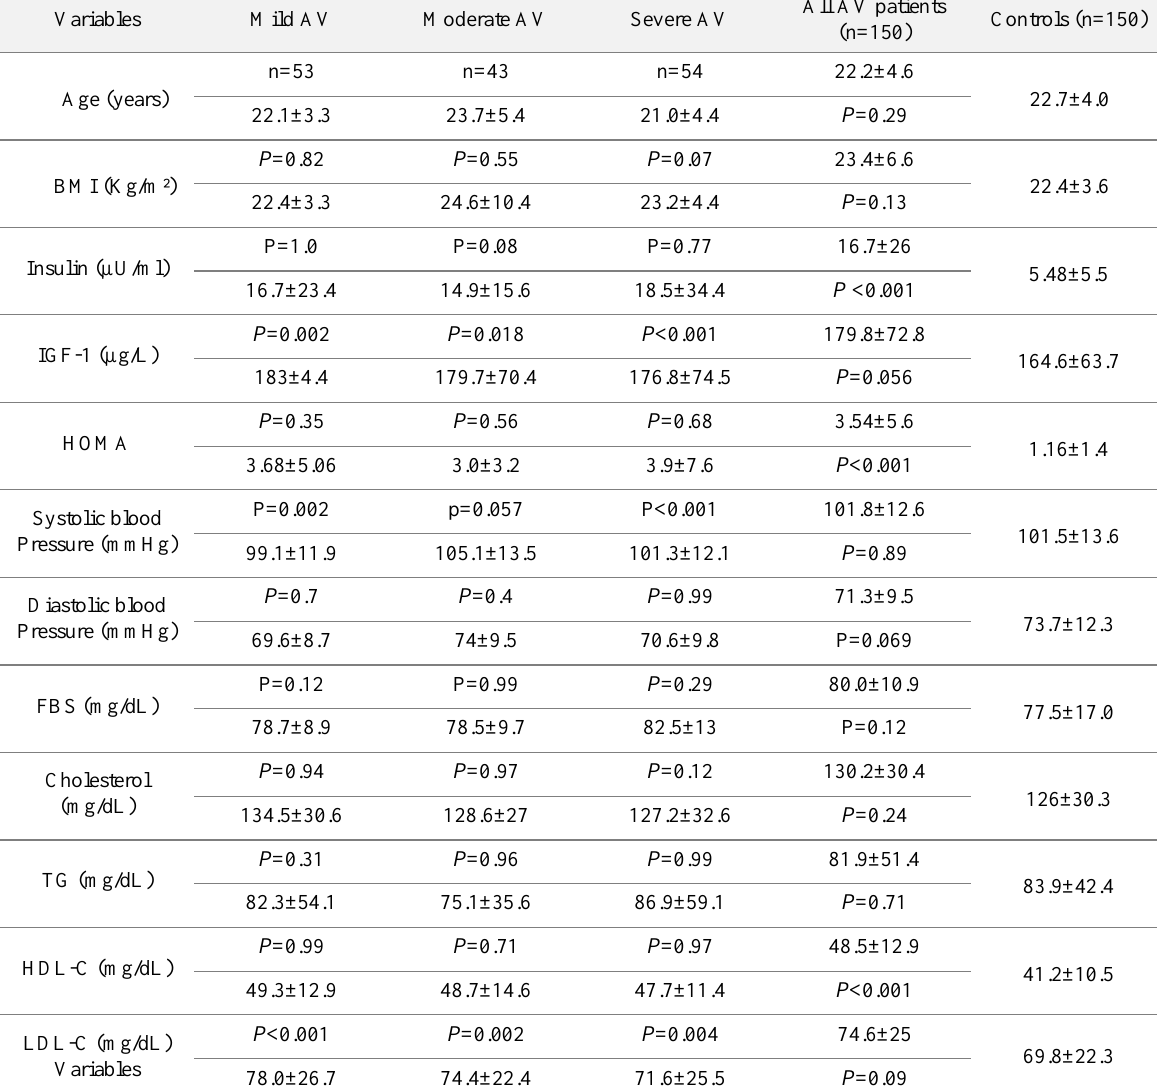
Table 1. Characteristics of AV patients and controls